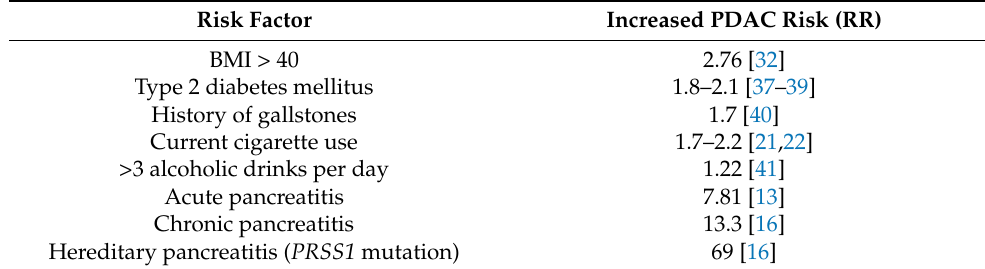
Table 1. PDAC risk